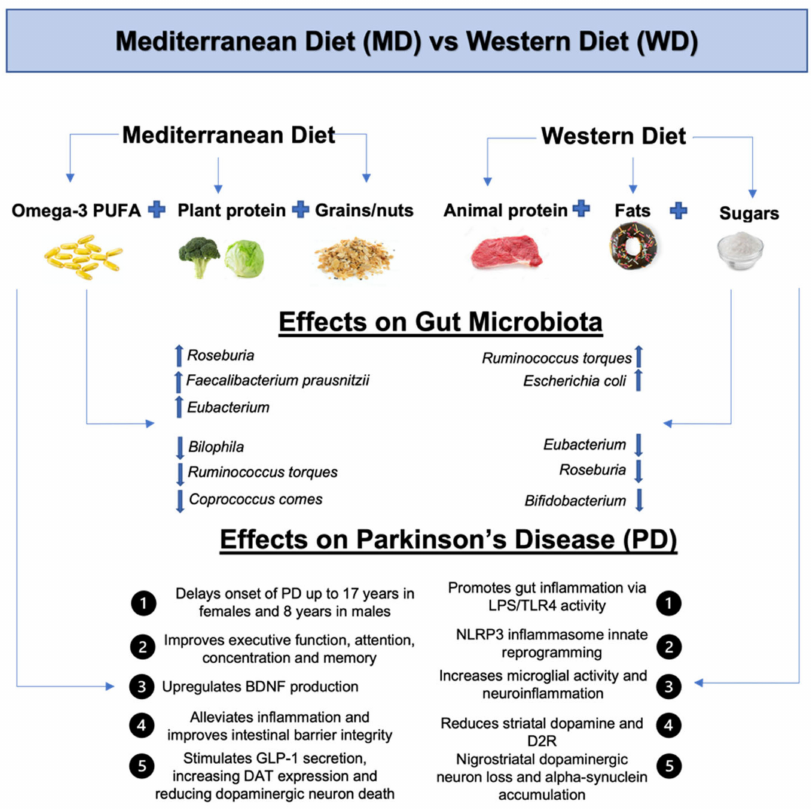
Figure 3. The effects of the Mediterranean Diet and Western Diet on gut microbiota and Parkinson’s Disease. The MD is composed of Omega-3 PUFA, plant protein, grains, and nuts. The MD increases concentrations of Roseburia, Faecalibacterium prausnitzii and Eubacterium, while lowering concentra- tions of Bilophila, Ruminococcus torques, Coprococcus comes. The MD effects on PD include delaying onset, improving executive function in PD patients, upregulating BDNF production, alleviating inflammation, improving intestinal barrier integrity and stimulating GLP-1 secretion, which in turn increases DAT expression and reduces dopaminergic neuron death. The WD is composed of animal proteins, fats and sugars. The WD increases concentrations of Ruminococcus torques and Escherichia coli, while reducing levels of Eubacterium, Roseburia and Bifidobacterium in the gut. The WD effects on PD include promoting gut inflammation via LPS/TLR4 activity, NLRP3 inflammasome innate reprogramming, increasing neuroinflammation, reducing striatal dopamine and D2R, leading to ni- grostriatal dopaminergic loss and α -synuclein accumulation. Abbreviations: PUFA, poly-unsaturated fatty acids; BDNF, brain derived neurotrophic factor; GLP-1, glucagon-like peptide 1; DAT, dopamine transporter; LPS, lipopolysaccharides; TLR-4, toll-like receptor 4; D2R, dopamine 2